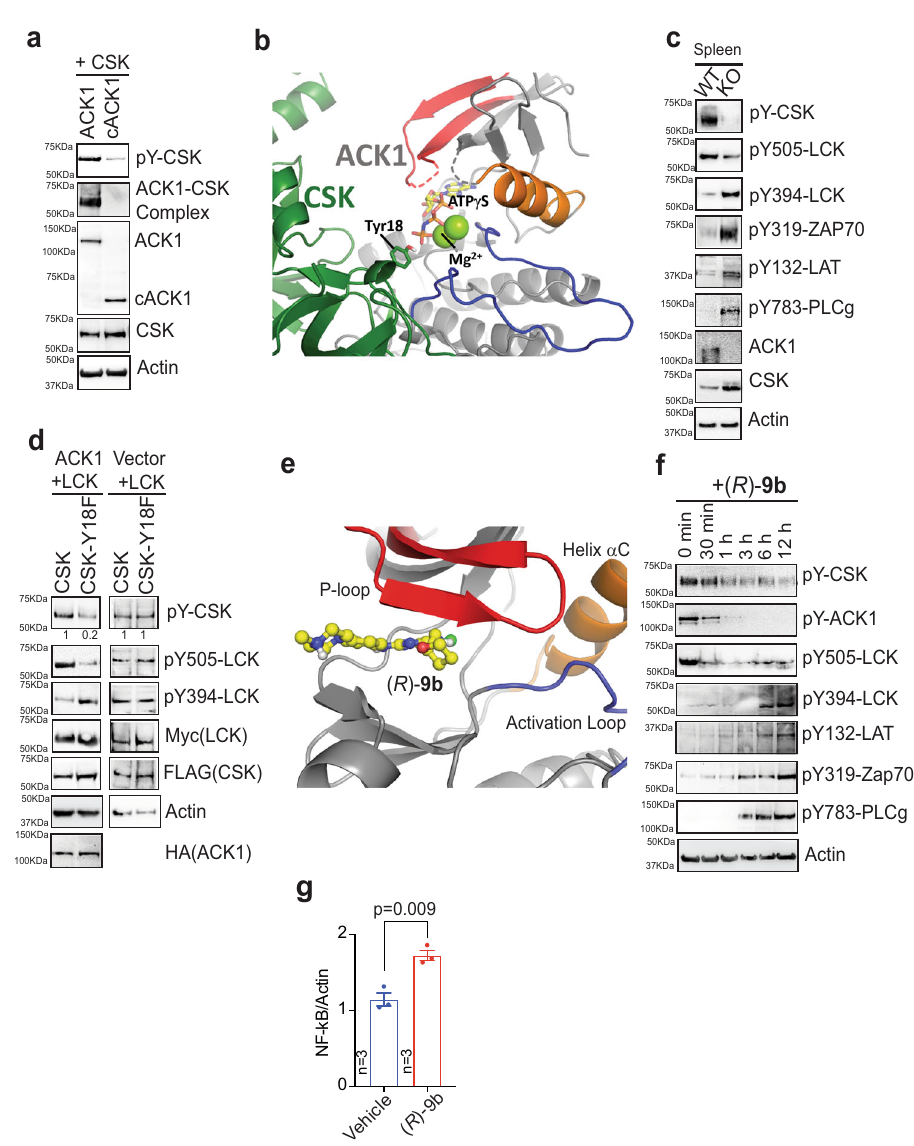
Fig. 2 | ACK1 phosphorylates CSK at Tyr18 in SH3 domain dampening T cell responsiveness. a HEK293T cells were co-transfected with FLAG-tagged CSK and HA-tagged ACK1 or cACK1. Post-MG132 (25 μ M, 3hr) treatment, lysates were immunoprecipitated with FLAG beads, followed by immunoblotting with p-Tyr antibodies (top panel). In addition, lysates were immunoprecipitated with HA beads, followed by immunoblotting with FLAG antibodies (2nd panel). b Docking model of CSK (green) bound to ACK1 (gray) with ATP γ S (yellow)/Mg 2+ (green) modelled into the active site of ACK1. The SH3 domain of CSK docks against the activation loop of ACK1 (red). c Lysates prepared from spleen of WT and Ack1 KO mice were immunoblotted with the indicated antibodies. Lysates were also immunoprecipitated with CSK antibodies, followed by immunoblotting with p-Tyr antibodies(2nd panel). d